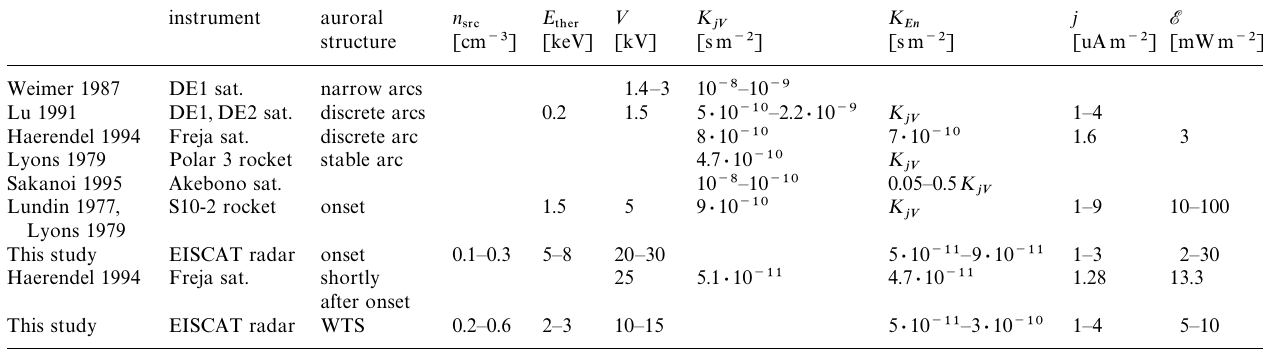
Table 1 . Table of parameters estimated in this study and from previous studies by Weimer et al . (1987), Lu et al . (1991), Haerendel et al . (1994), Lyons et al . (1979) Sakanoi et al . (1995) and Lundin (1977) instrument